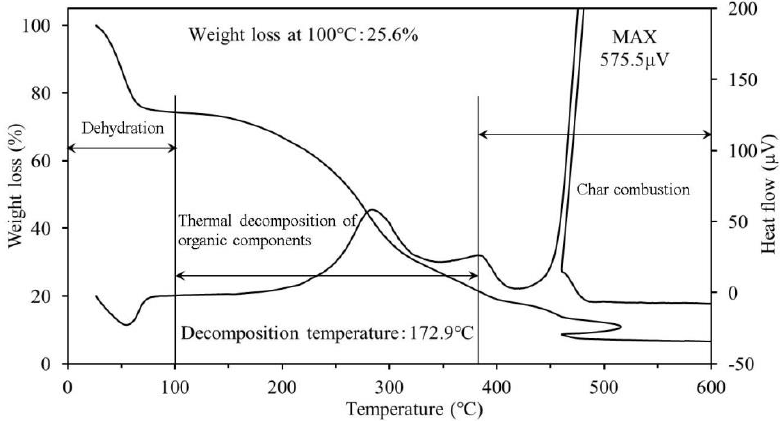
Figure 6. TG-DTA results for the SSSR sample.